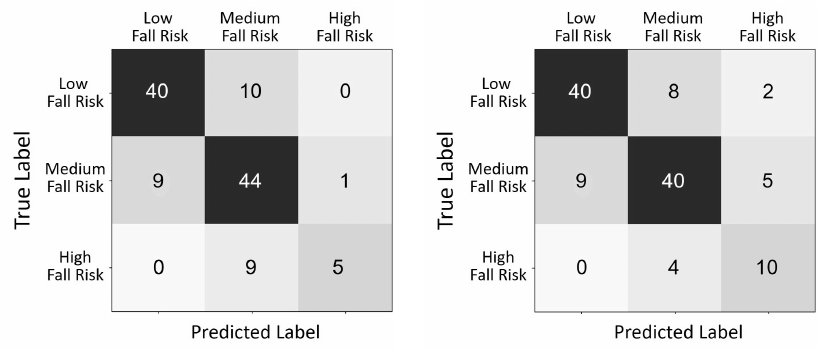
Figure 5. Confusion matrix between the true risk of fall as determined by the physiotherapists and the predicted risk of fall ( left ). False negatives can be reduced by manipulating the thresholds ( right ). The MSE values are 0.25 and 0.29, respectively.